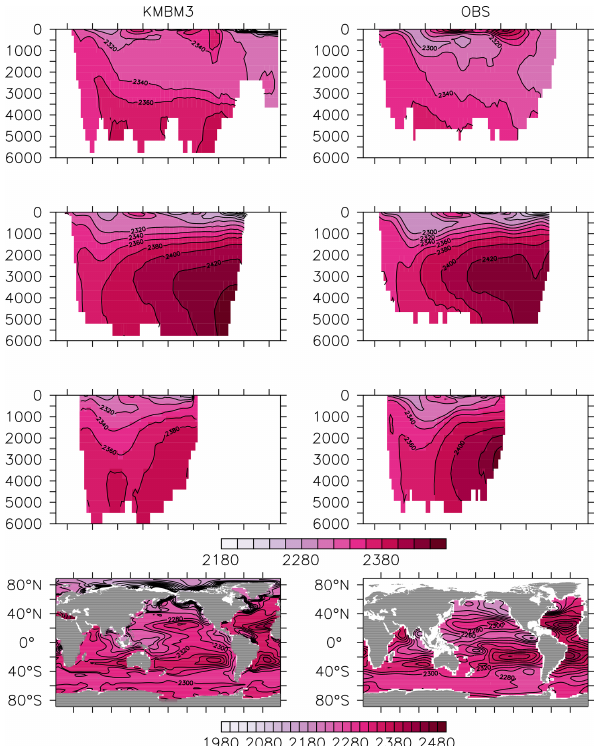
Figure 11. Model (left column) year 2014 DIC (µmolkg − 1 ) av- eraged by basin compared to GLODAP (right column; Key et al., 2015; Lauvset et al., 2016). Regions are as follows: Atlantic (top row), Pacific (second row), Indian (third row) and global surface (bottom